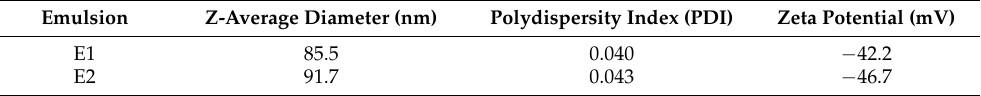
Table 3. Average particle size diameters, polydispersity index and zeta potential values of the latexes.